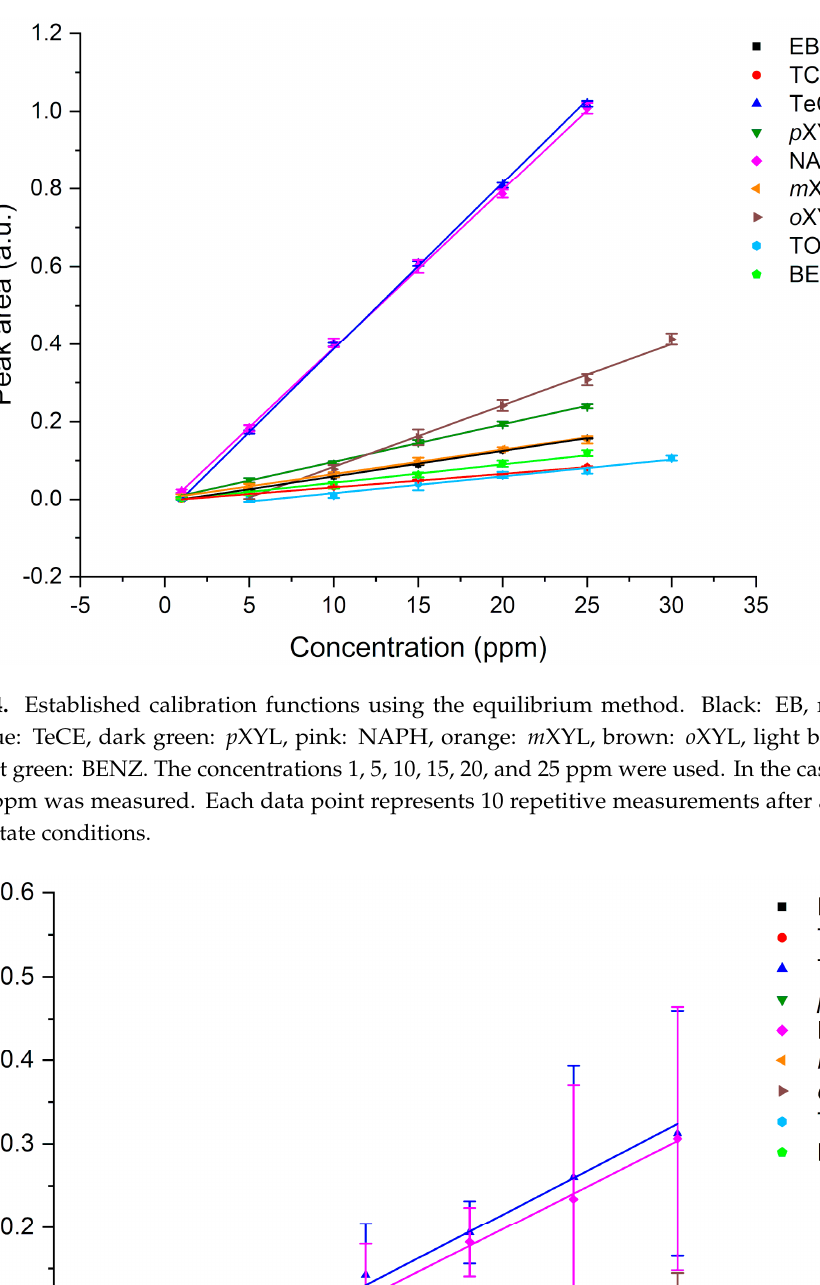
Figure 5. Calibrations functions in the concentration range from 1 to 25 ppm obtained using the kinetic method, i.e., evaluating the slope of the tangent of the linear range of enrichment curve. Black: EB, red: TCE, dark blue: TeCE, dark green: p XYL, pink: NAPH, orange: m XYL, brown: o XYL, light blue: TOL, and light green: BENZ.